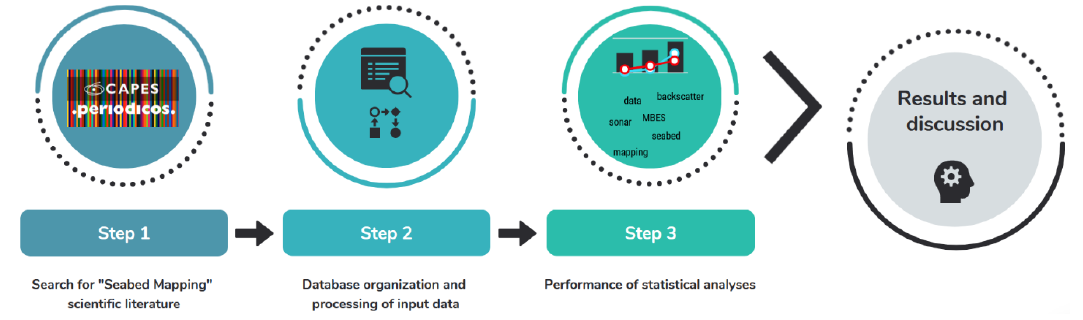
Figure 1. Methodological flow.